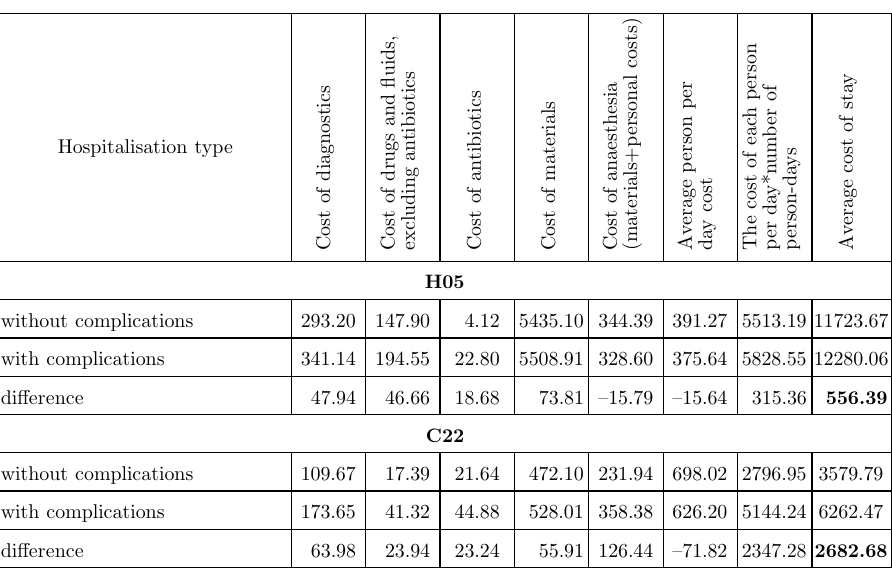
Table 3. Cost data for the C22 and H05 groups (PLN)